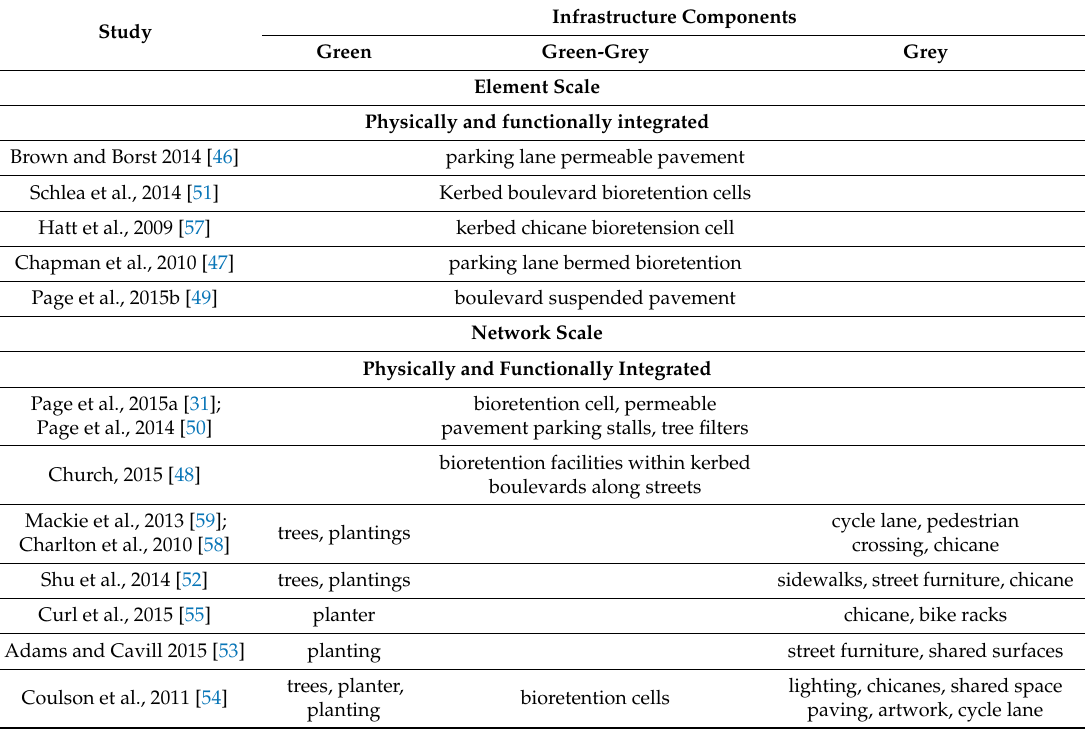
Figure 4. Example of functionally integrated street infrastructure (plan view; not to scale). Table 2. Integration of street infrastructure elements by